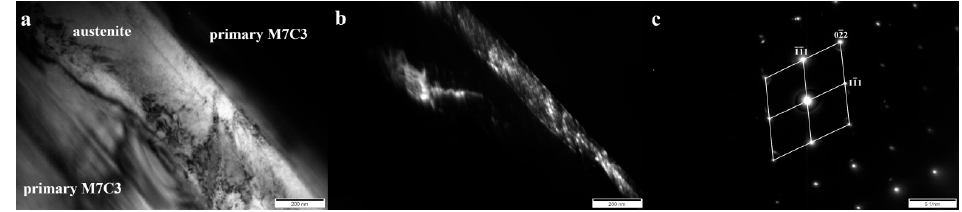
Figure 7. ( a ) Bright field image of austenite between primary M 7 C 3 carbides in layer II. ( b ) Dark field image obtained from reflection (1 ̅ 1 ̅ 1) from austenite—shown in ( c ). ( c ) Selected area diffraction pattern (SAED) of austenite (011) shown in ( a ), along with the solution. Transmission electron microscope, 150 kV.